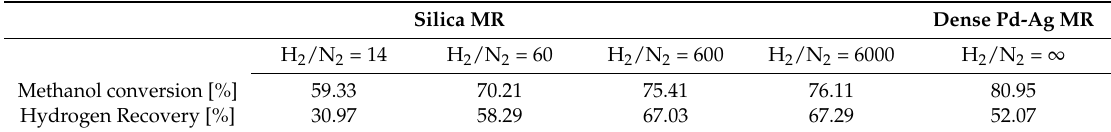
Table 7. Evaluation of the perm-selectivity effects on silica MR performance over to the dense Pd-Ag MR (at 523 K, 2 bar, sweep factor = 2.5, H 2 O/CH 3 OH = 1 and gas hourly space velocity = 1700 h − 1 ). With permission to reprint from Elsevier from Ghasemzadeh et al. [43].